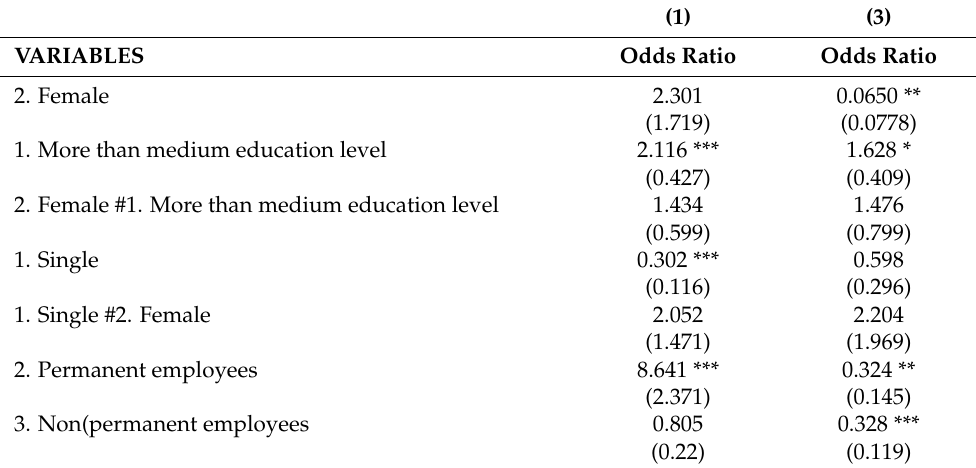
Table A8. Logit model with interaction effects. Dependent variables: being insured (second column) and choosing informality (third column). Source: Sahwa